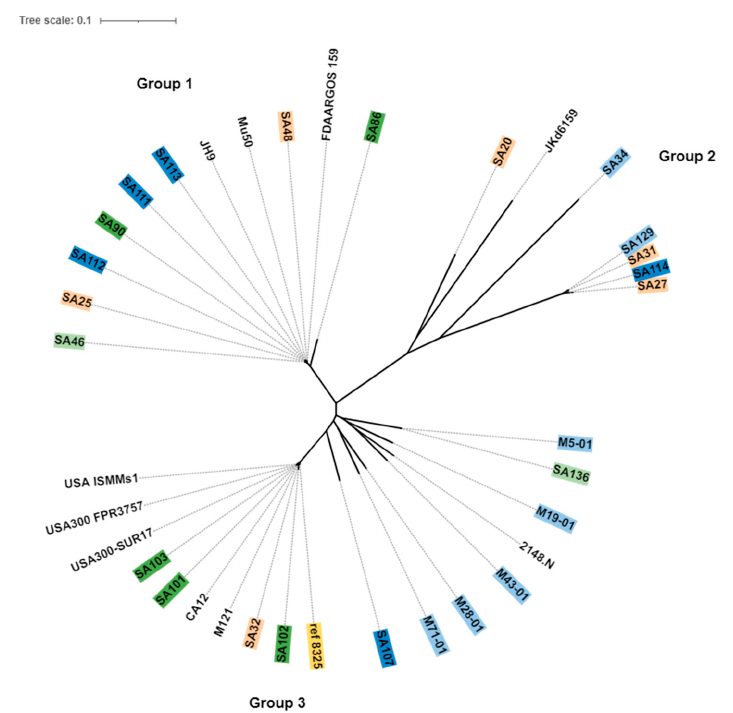
Figure 6. Core genome phylogeny of S. aureus , using Parsnp. S. aureus strain NCTC 8325, was used as a reference strain (yellow). Isolates highlighted in shades of green indicate conjunctivitis strains; dark green indicates conjunctivitis strains from USA and light green indicates conjunctivitis strains from Australia. Shades of blue indicate MK strains; dark blue represents MK strains from USA and light blue represents MK strains from Australia. The peach color indicates strains from niCIE and strains with no color indicate non-ocular isolates. The tree was constructed using online webtool itol (interactive tree of life, https://itol.embl.de/ (accessed on 4 April 2022).